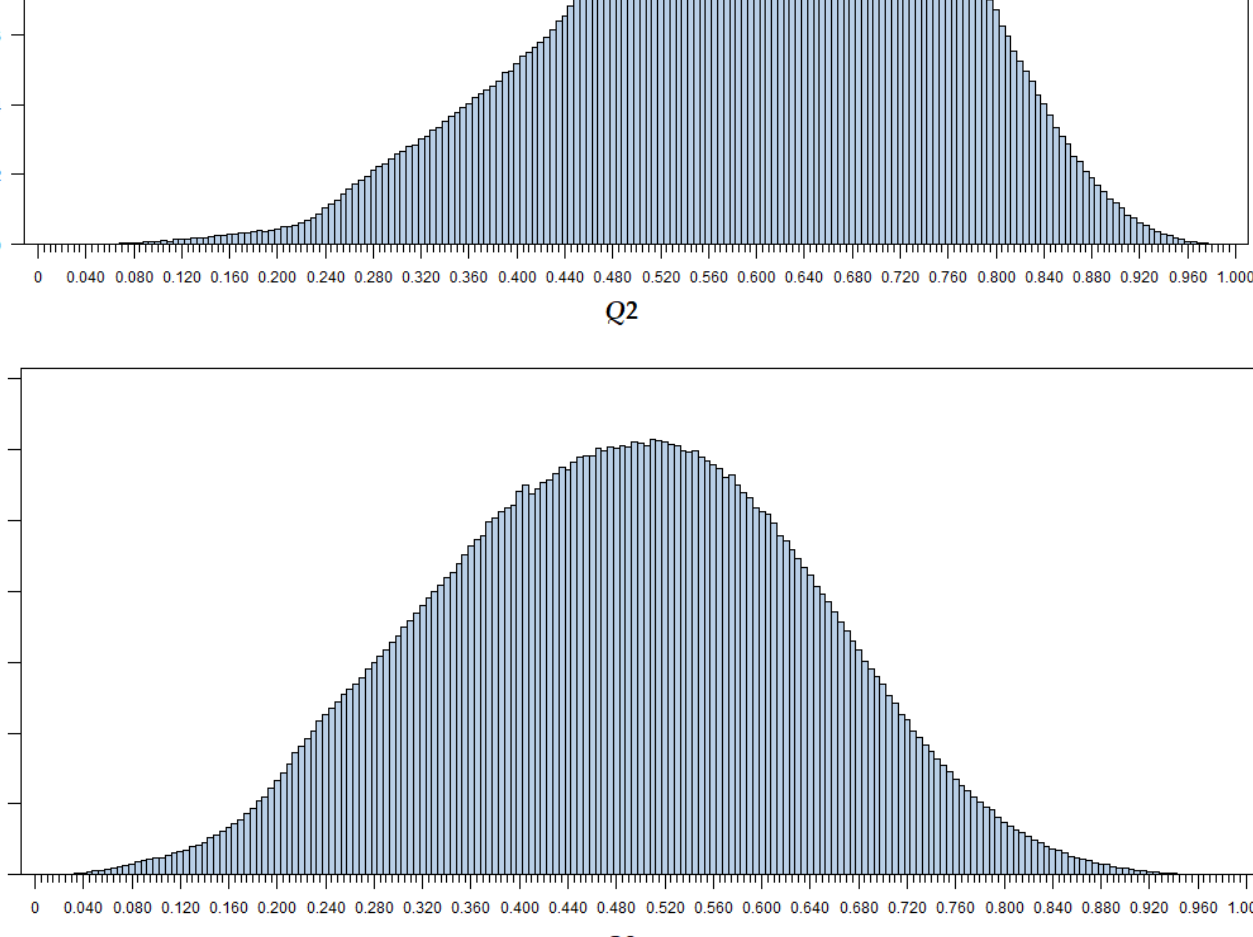
Figure 11. Distributions of the quality measures Q 2 (standardized version of EH ) and Q 3 (standardized version of ER ), of the mesh of the real model of the bouton. Probability (percent) − vertical